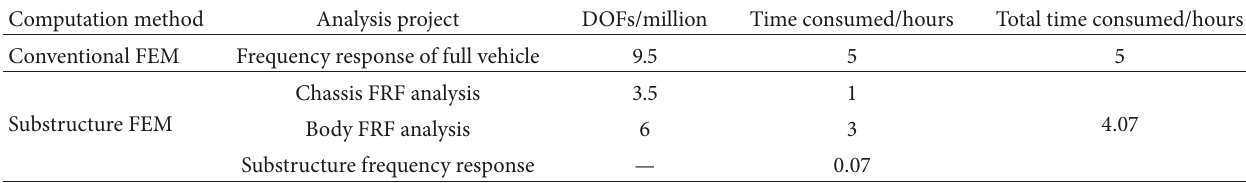
Table 3: Analysis time of finite element